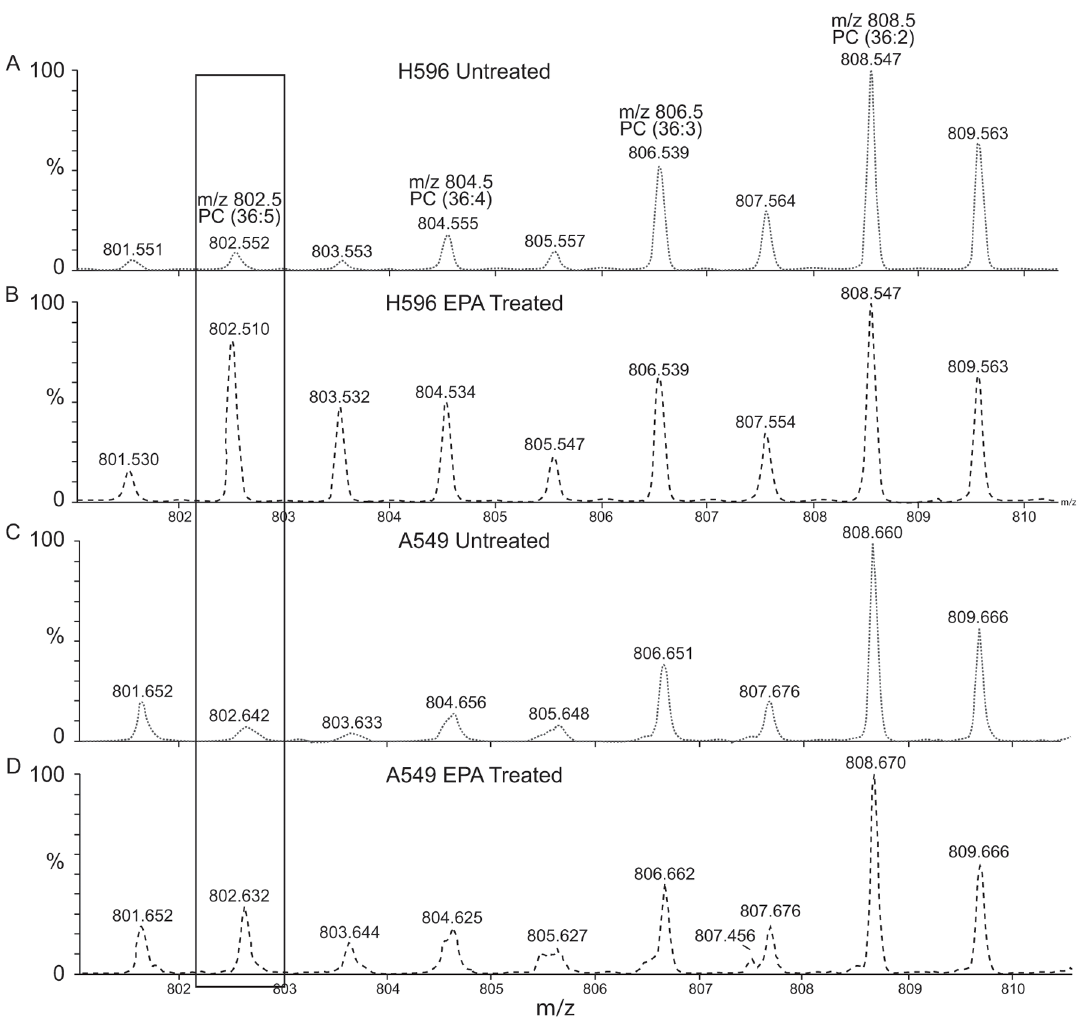
Figure 4. Representative mass spectrum comparing the spectral region from m/z 800 2 810 from H596 untreated (A) and EPA treated (B) cells. A significant increase is observed for m/z 802.5, which corresponds to a PC (36:5) fatty acid. MS/MS confirmed that PC (16:0/20:5) was a component of the observed m/z value (data not shown). Spectra shown in (C) and (D), corresponding to the A549 cells line untreated and EPA treated; respectively, also show an increase in m/z 802.5 after treatment with EPA. However, this increase is significantly less than the increase observed for the H596 cell line.